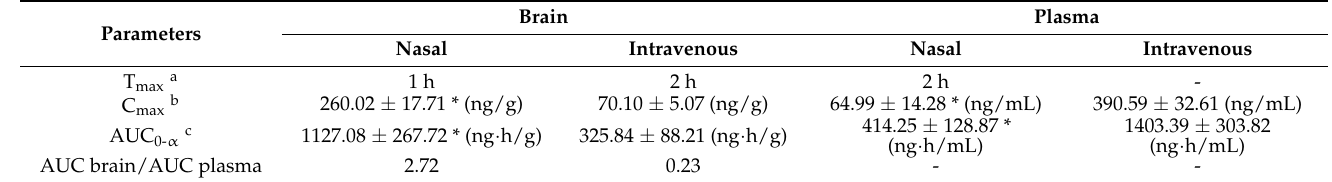
Figure 12. The brain drug concentration–time profile of darunavir after administration by nasal (optimized in situ gel, 30 µL, 2.4 mg/kg) and intravenous (solution, 0.4 mL, 2.4 mg/kg) routes in rats. The data presented are the average of six animals at every time point. Table 5. Pharmacokinetic parameters of darunavir in brain and plasma after administration by nasal (optimized in situ gel, 30 µ L, 2.4 mg/kg) and intravenous (solution, 0.4 mL, 2.4 mg/kg) routes in Sprague Dawley rats. The data presented are the average of six animals at every time